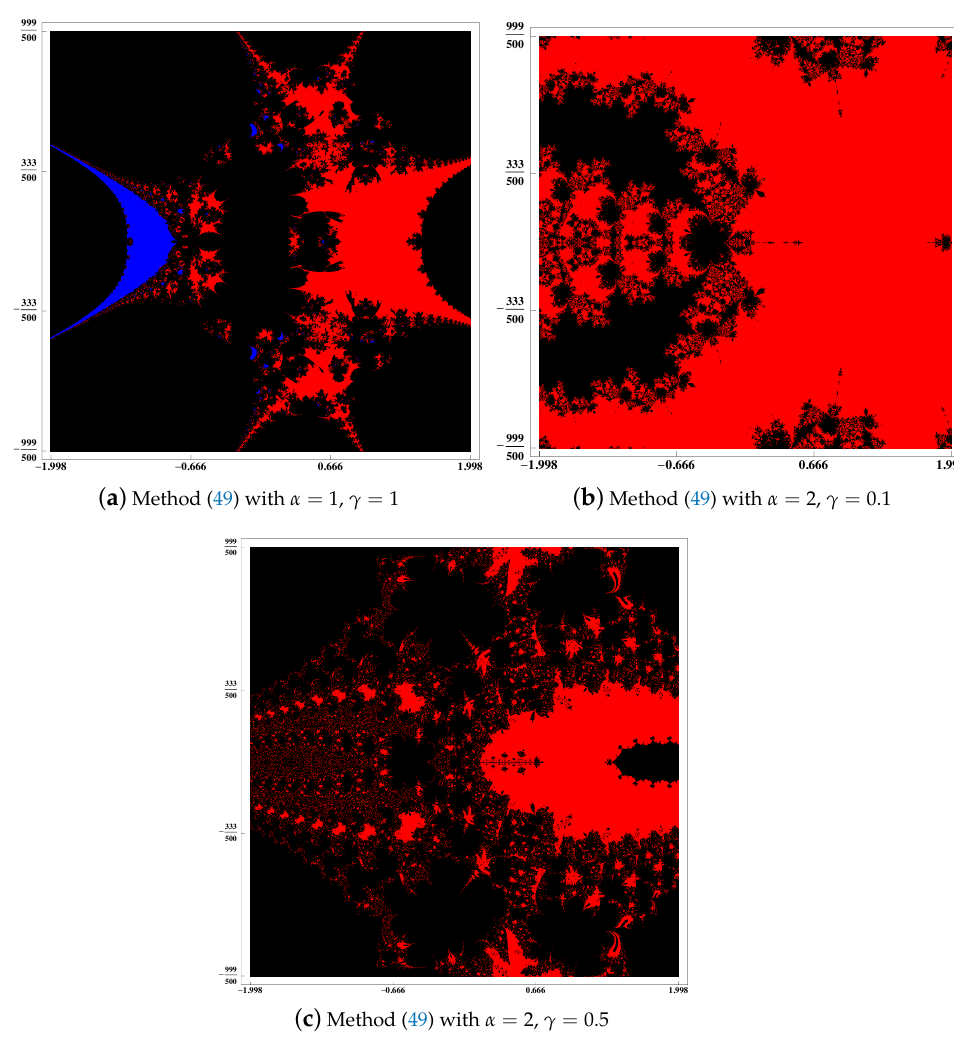
Figure 4. Basins of attraction associated to the method (49) applied to polynomial p ( z ) = ( z − 1 ) 2 ( z + 1 ) with different values for